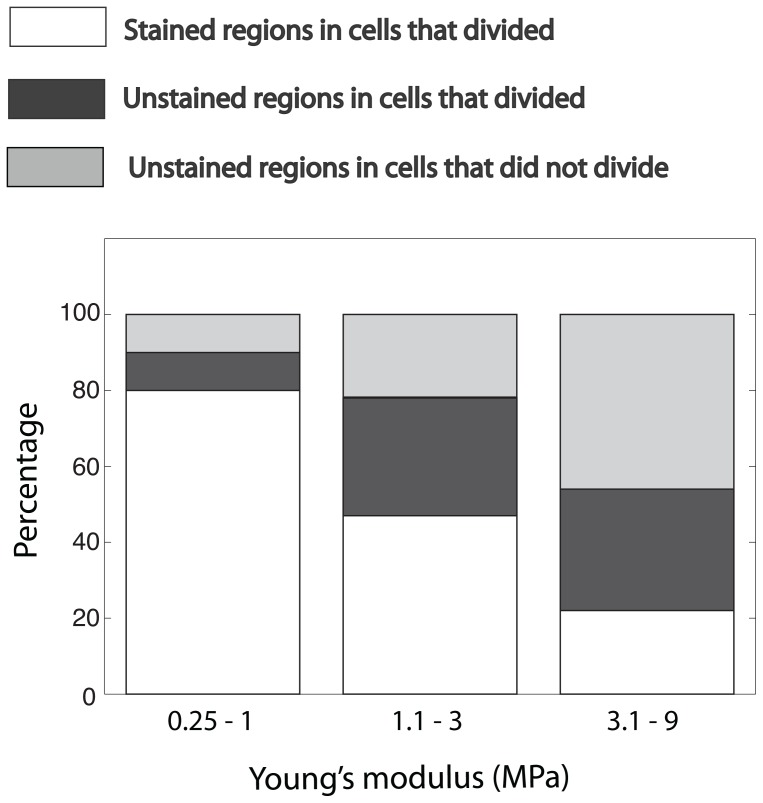
Frequency distribution of Young's moduli (E) for stained and unstained structural components.Data were grouped into 3 ‘stiffness’ categories. Number of samples in each category: 0.3<E<0.99 MPa n = 20; 1<E<2.99 MPa n = 32; E>3 MPa n = 37.